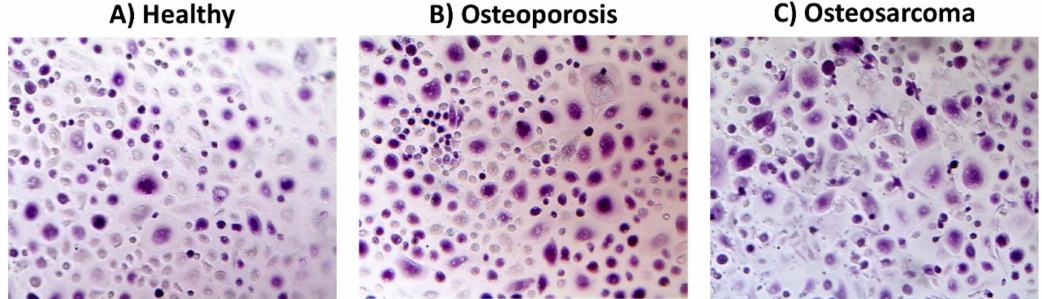
Figure3. Representationofthemultinucleatedtartrate-resistantacidphosphatase(TRAP)( + )osteoclasts obtained by colorimetric assay (TRAP assay). The figure shows that osteoclasts (in purple) derived from ( B ) a postmenopausal woman with osteoporosis and from ( C ) an osteosarcoma patient are more active, as shown by the more intense staining and the larger size, with respect to osteoclasts derived from ( A ) a healthy